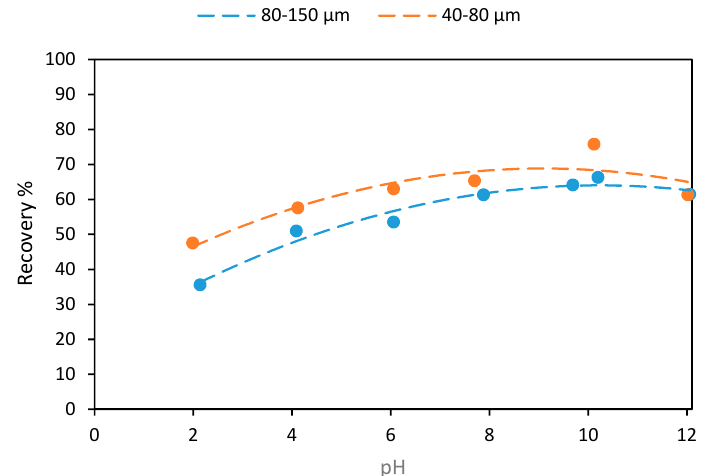
Figure 2. Effect of pH on spodumene flotation for the coarse and fine fractions.